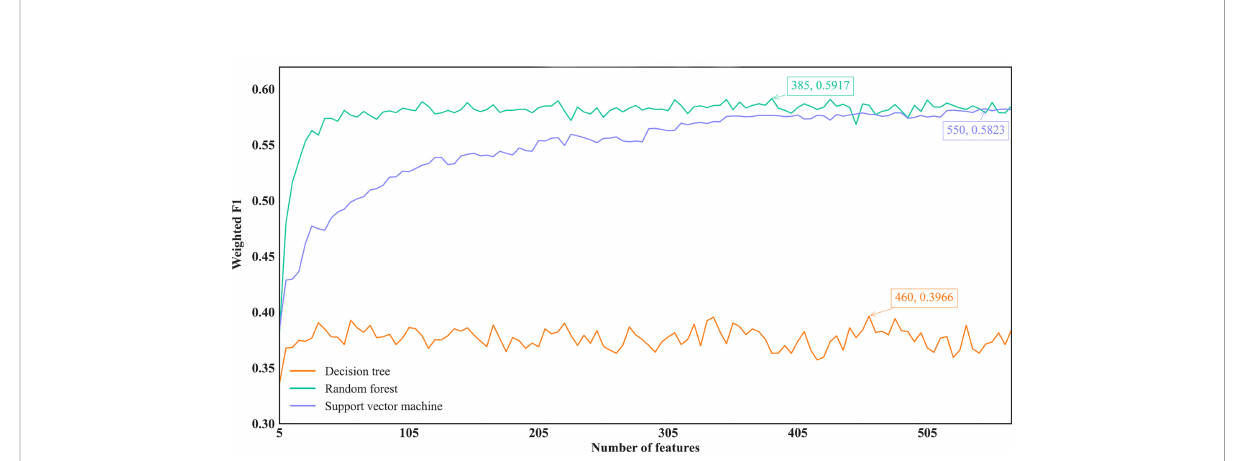
FIGURE 6 IFS curves of different classi fi cation algorithms on the MCFS feature list. Three classi fi cation algorithms provided highest weighted F1 values of 0.3966, 0.5917 and 0.5823, respectively, based on top 460, 385 and 550, respectively, features in the